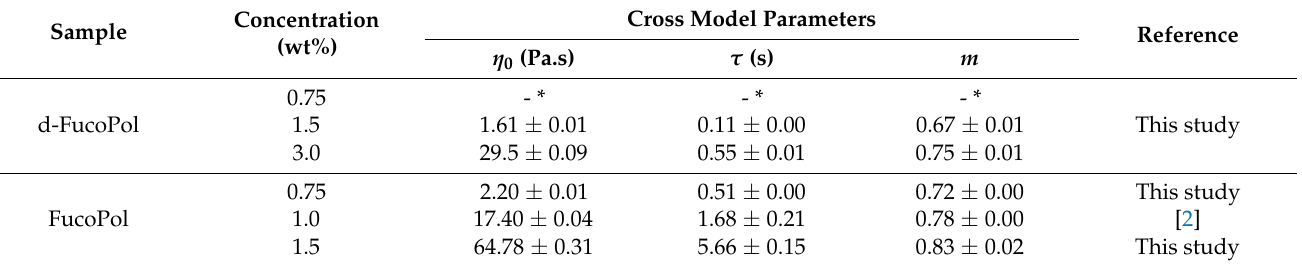
Table 2. Cross model parameters estimated for d-FucoPol and Fucopol solutions. η 0 —apparent viscosity of the first Newtonian plateau (Pa · s); τ —relaxation time (s); and m —dimensionless